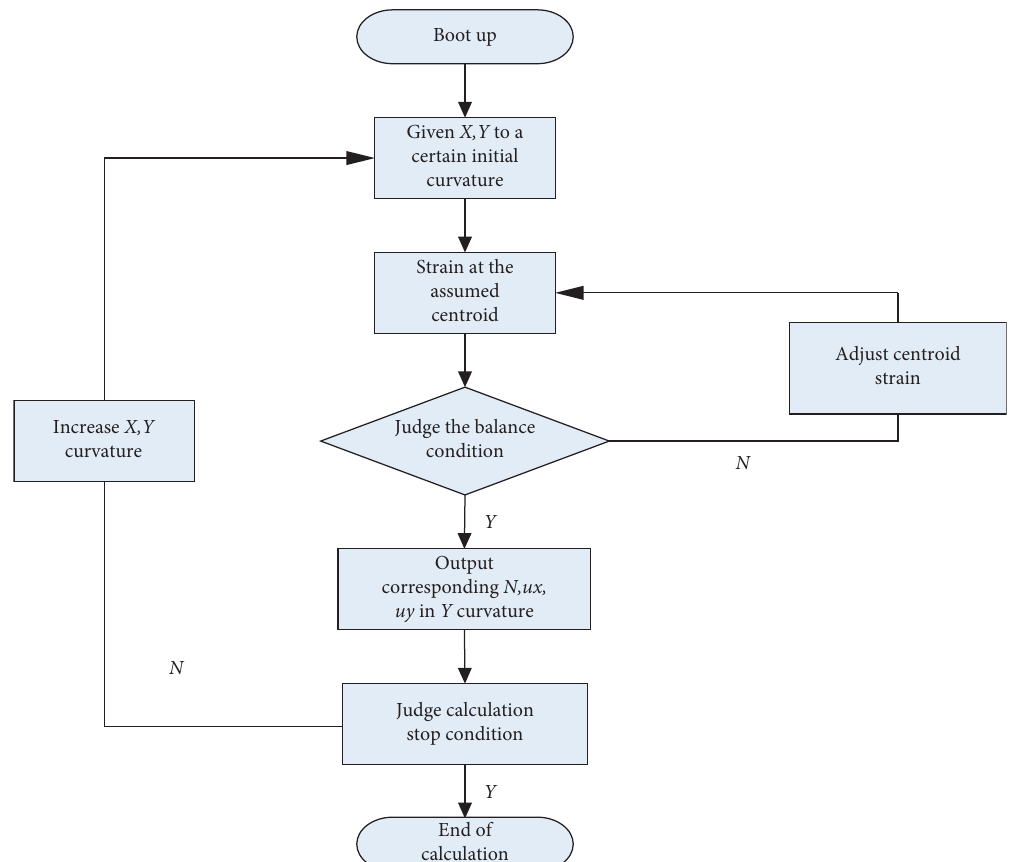
Figure 1: The fiber model program flow chart of load path